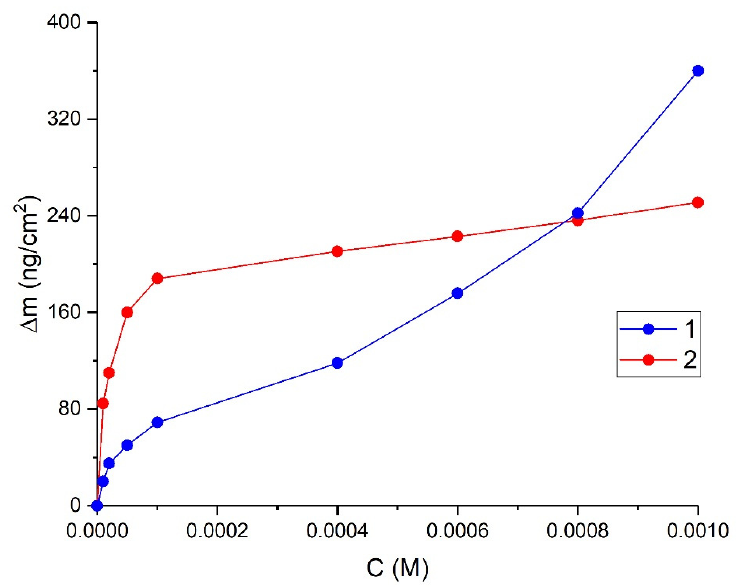
Figure 2. Isotherm of irreversible adsorption of organosilanes on the surface of freshly sprayed aluminium from aqueous solution: ( 1 ) DAS; ( 2 ) VS.